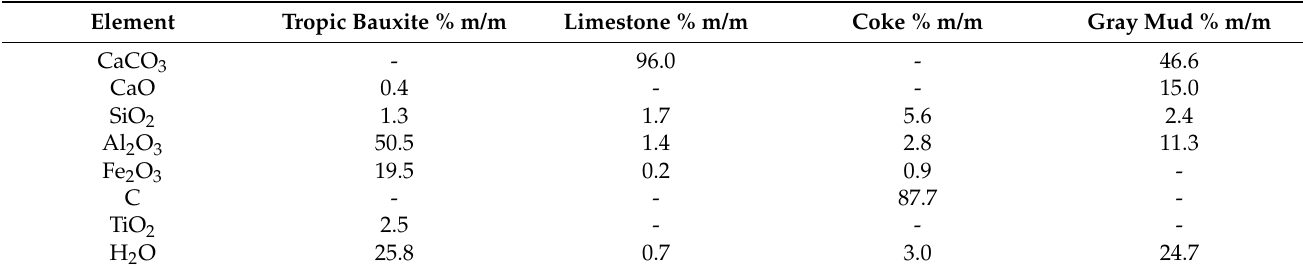
Table 1. Chemical composition of main input streams.